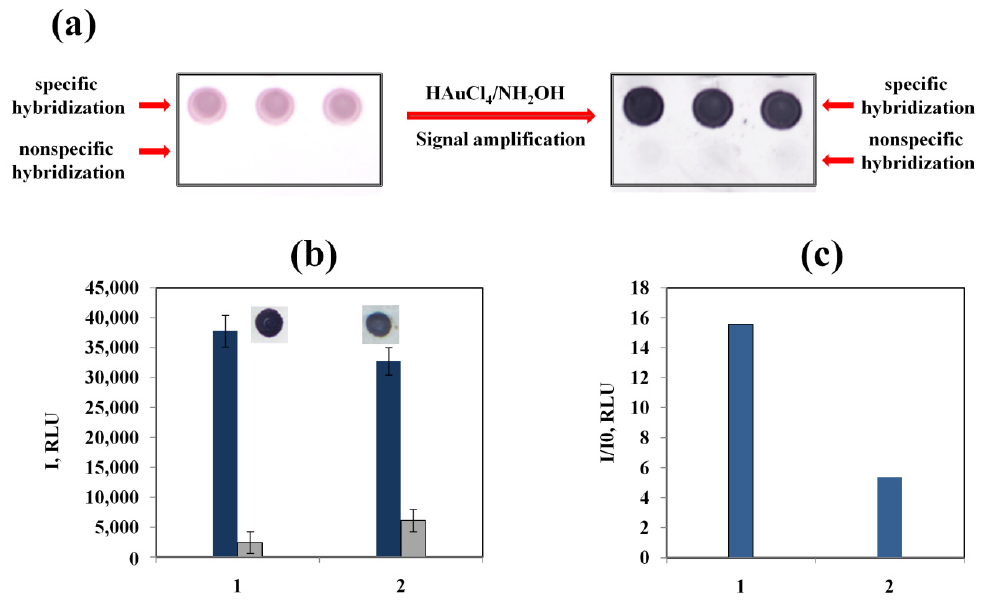
Figure 8. Images of nitrocellulose microarrays before and after the enhancement of AuNP labels using an enhancement solution at optimized reagent concentrations and pH (0.7 mM tetrachloroauric acid and 50 mM hydroxylamine, pH 3.5) ( a ); the staining intensities of specific (blue) and background (gray) spots with different orders of reagent mixing ( b ); and signal-to-noise ratios with different orders of reagent mixing ( c ). Target oligonucleotide (50 pM) was hybridized on the microarrays. 1—the pH value of tetrachloroauric acid solution was adjusted to 3.5 before the mixing with hydroxylamine; 2—the reagents were mixed without adjusting the pH value.